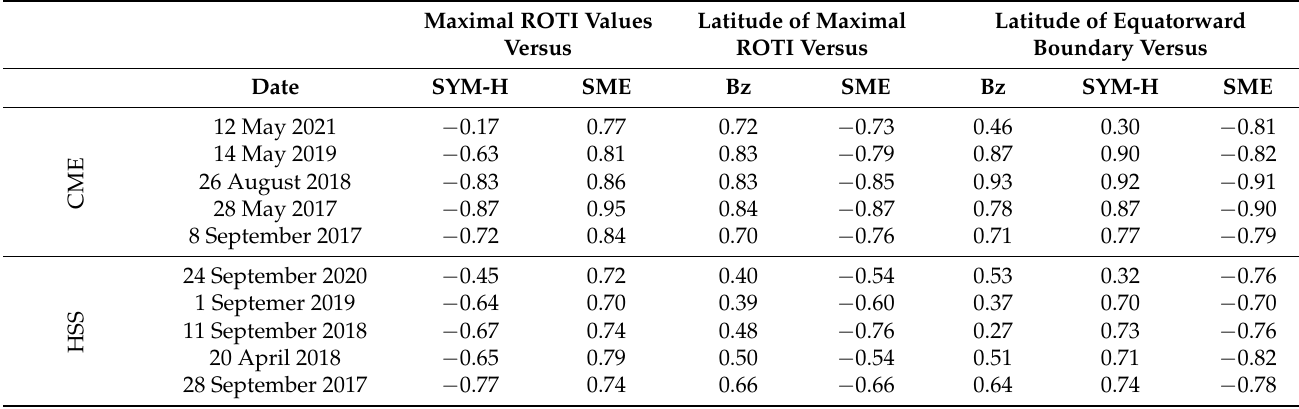
Table 2. Cross-correlation maxima. Maximal ROTI Values Latitude of Maximal Versus ROTI Versus